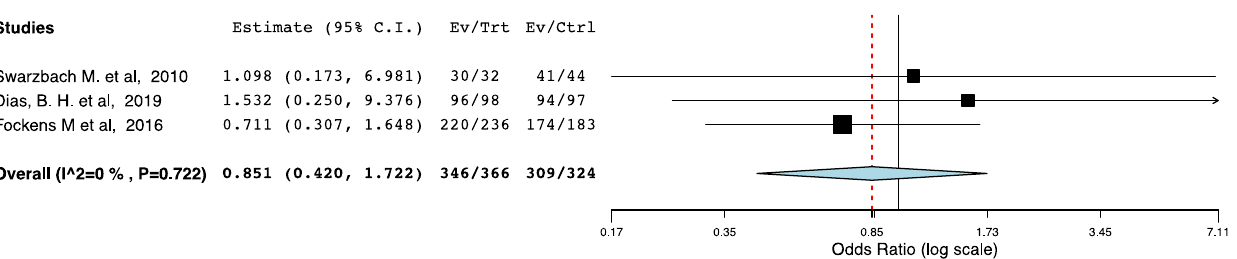
Figure 10. Forest Plot: One-year post-transplant graft Survival (ERAS vs. traditional perioperative care).